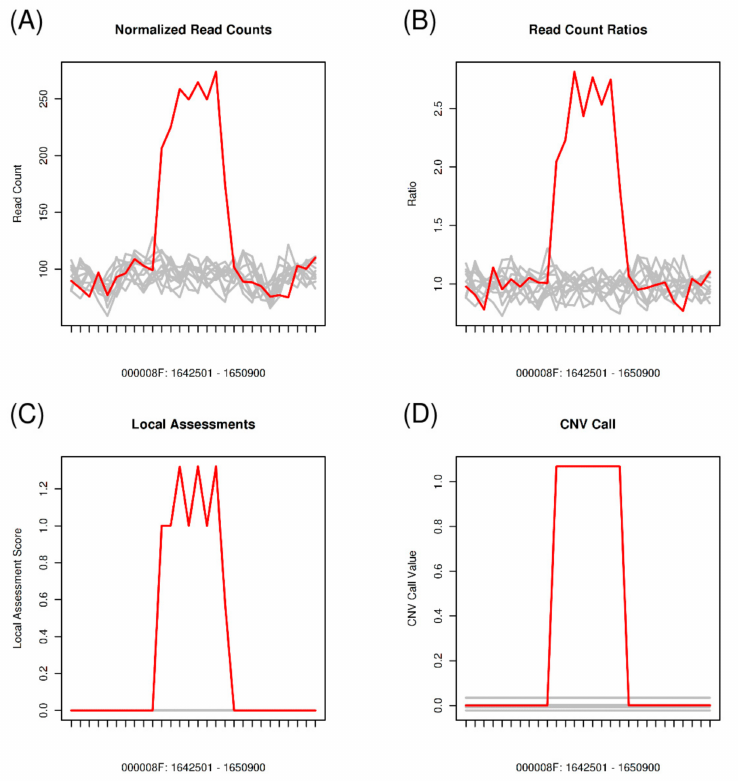
Figure 4. An illustration of a CNV detected at region 1,645,501–1,647,900 of contig 000008F. Isolate S547 (the red line) had the copy number 5 (copy number gain), and the other 11 isolates (grey lines) had the normal copy number 2. The candidate GN104ID162_006610 for AvrLr24 was identified by this CNV (Supplementary File S6). The x -axis represents the genomic position, and the y -axis represents ( A – D ) normalized read counts, read count ratios, local assessment scores, and CNV calls produced by the segmentation algorithm